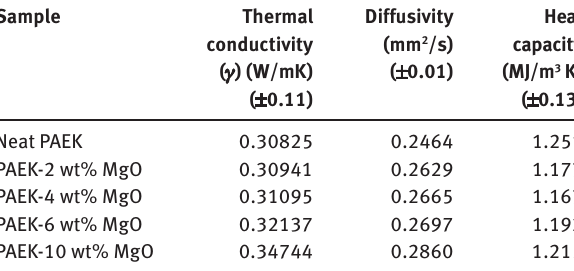
Table 2: Thermal conductivity of PAEK-MgO